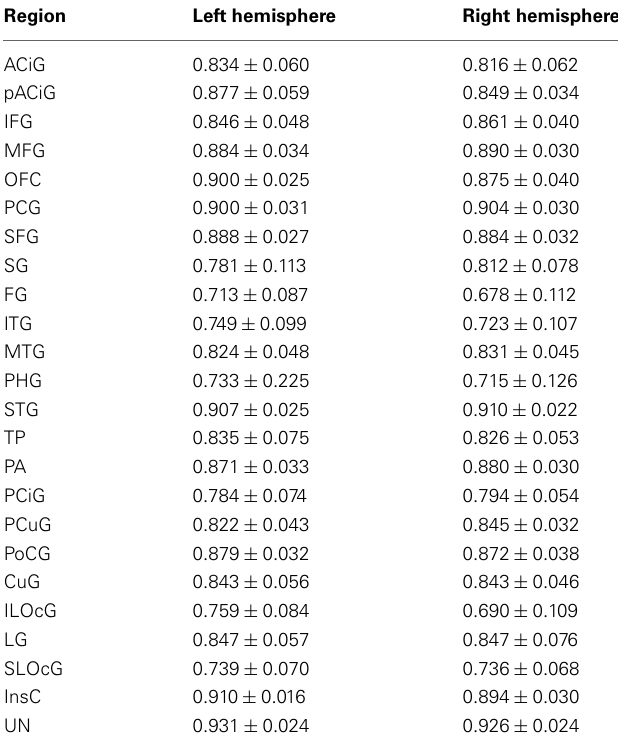
Table 6 | The Dice indices of regions. Region Left hemisphere Right